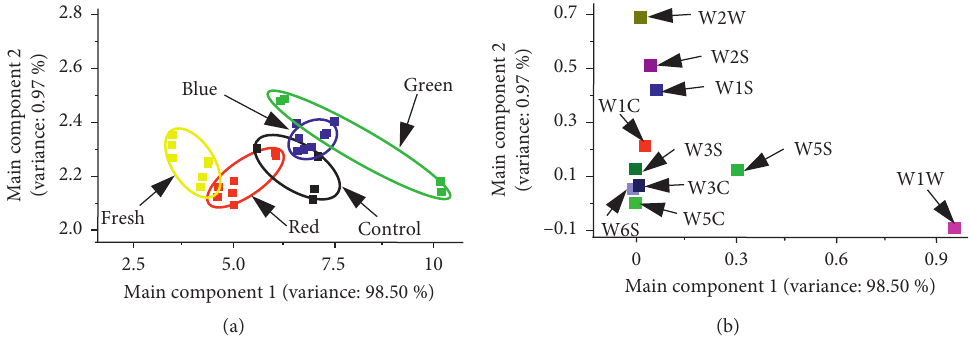
Figure 6: (a) Effect of light exposures on aroma of fresh-cut watermelon and (b) contribution of the electrode to the principal